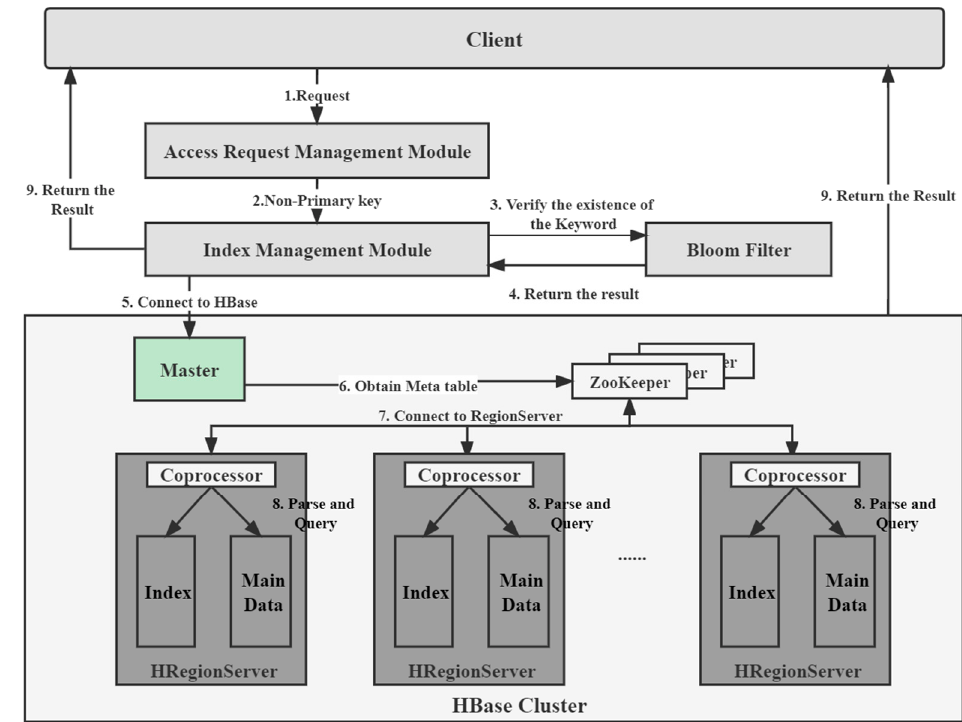
Figure 13. The retrieval steps of the secondary index .